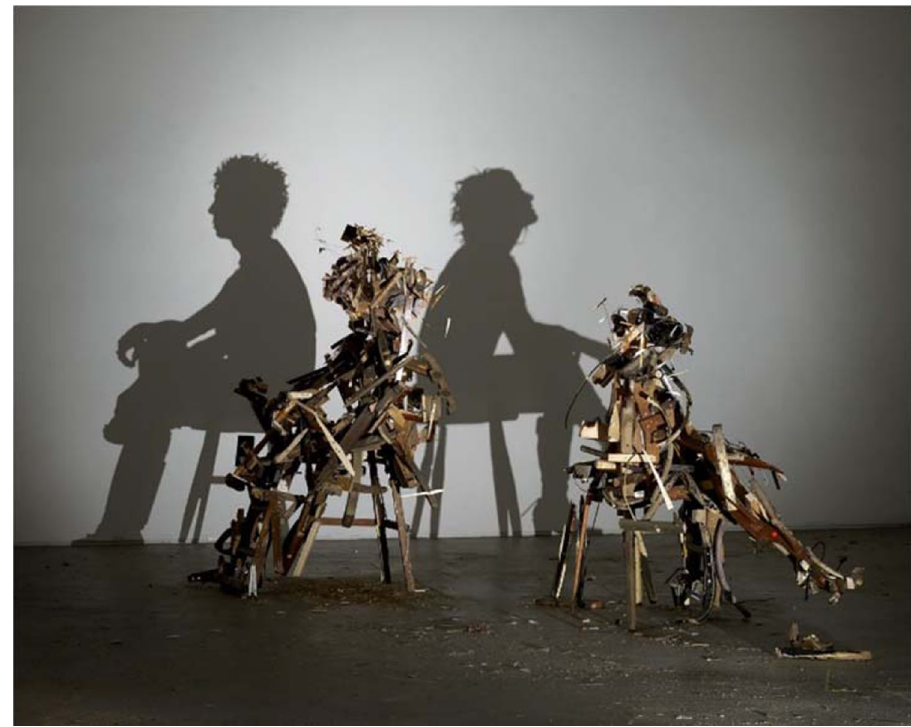
Fig. 1 Example of how outcomes (in this case the projected shadows) of an incompletely characterized object may cause misinterpretation. Projected shadows of self-portraits created by ordinary things (e.g., rubbish). Tim Noble and Sue Webster, Wild Mood Swings, 2009 – 10; © Tim Noble and Sue Webster. All Rights Reserved, DACS/Artimage 2021. Photo: Andy